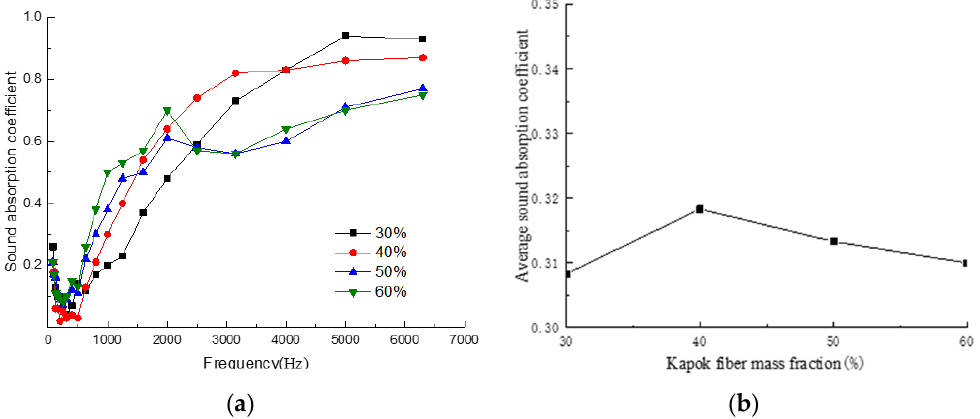
Figure 3. Influence of mass fraction on sound-absorption coefficient: ( a ) sound-absorption coefficient and ( b ) average sound-absorption coefficient.